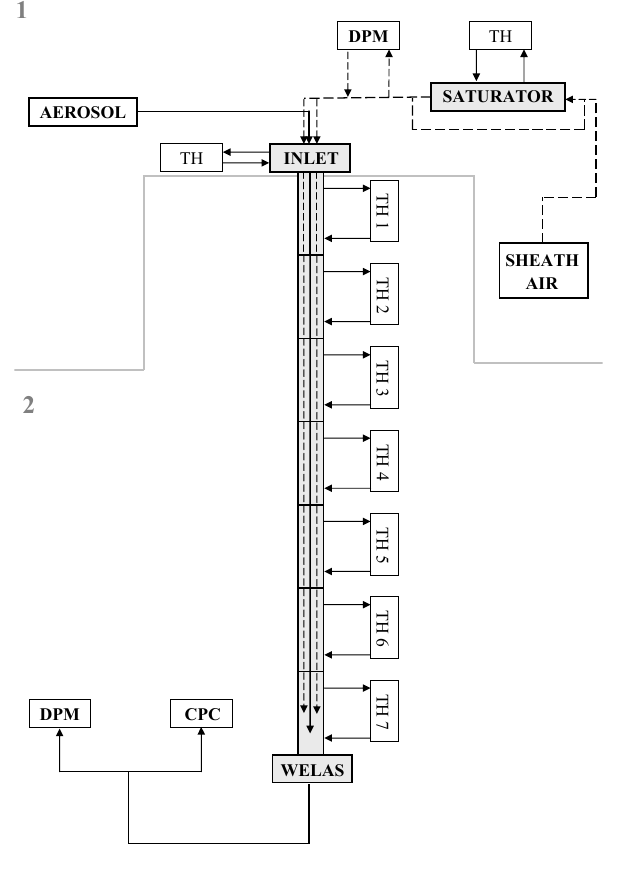
Fig. 2. Setup of particle conditioning (1) and LACIS laminar flow tube